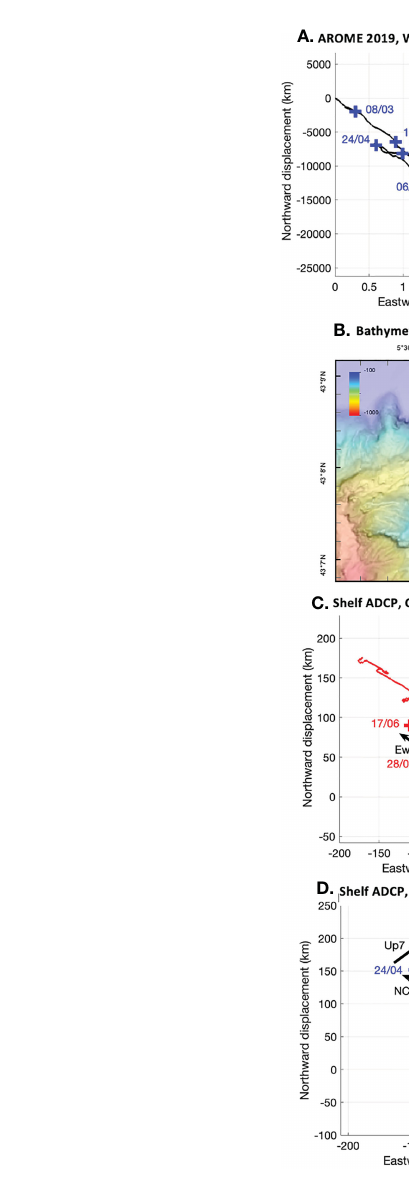
FIGURE 3 (A) Hodograph of the wind determined by the AROME meteorological model at 10 m above the surface during the CASSISED 2019 measurement period. ‘ M ’ refers to the direction of the Mistral. (B) Bathymetric map at the shelf ADCP (m). Hodograph of the eulerian current measured by the shelf ADCP averaged on: (C) the surface layer of 65 m depth and (D) on the bottom layer. ‘ Up 4 ’ , ‘ Up 5 ’ , ‘ Up 6 ’ and ‘ Up 7 ’ correspond to upwelling events. ‘ Ew ’ refers to easterly wind. ‘ NC ’ corresponds to Northern Current intrusion. Blue crosses and lines refer to events in non-strati fi ed conditions and red crosses and lines refer to events in strati fi ed conditions. (E) Hodograph of the wind determined by the AROME meteorological model at 10 m above the surface during the UPCAST 2017 measurement period. ‘ M 1 ’ , ‘ M 2 ’ and ‘ M 3 ’ correspond to Mistral events. ‘ Ew ’ refers to easterly wind. (F) Bathymetric map at the ADCP B (m). Hodograph of the eulerian current measured by the ADCP B: (G) at 22 m depth and (H) at 117 m depth. ‘ Up 1 ’ , ‘ Up 2 ’ and ‘ Up 3 ’ correspond to upwelling events. ‘ Re 2 ’ is the relaxation phase of the ‘ Up 2 ’ upwelling